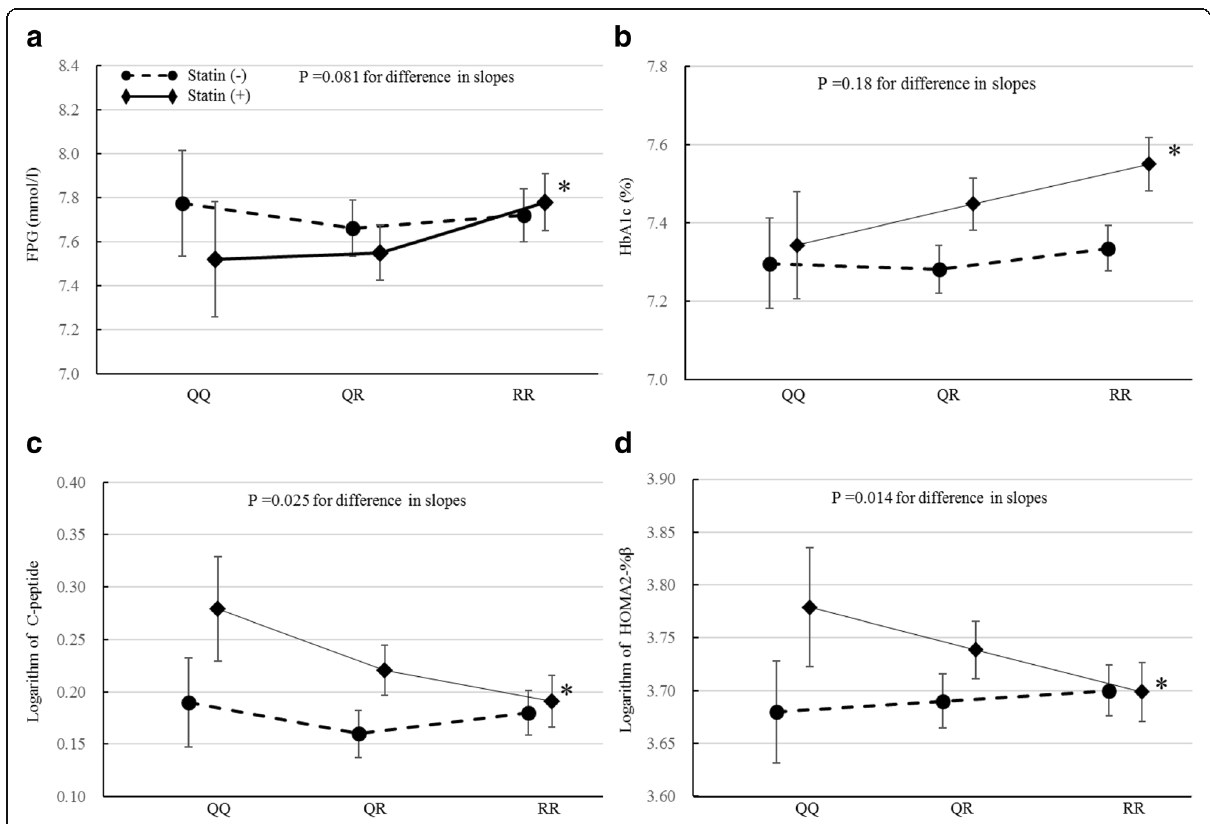
Fig. 1 Association of PON1 Q192R polymorphism with FPG ( a ), HbA1c ( b ), serum C-peptide ( c ), and HOMA2-% β ( d ) after stratified analysis by statin therapy. Data are expressed as adjusted mean (95% CI) referring to ANCOVA; P value refers to multiple regression analysis. FPG and HbA 1c : adjusted for gender, age, BMI, smoking, alcohol, leisure-time physical activity, duration of diabetes, SU, glinide, thiazolidine, α -GI, biguanide, insulin. C-peptide and HOMA2-% β : adjusted for gender, age, BMI, smoking, alcohol, leisure-time physical activity, duration of diabetes, HbA 1c , SU, glinide, thiazolidine, α -GI, biguanide, insulin. * P < 0.05 for trend in the group with statins